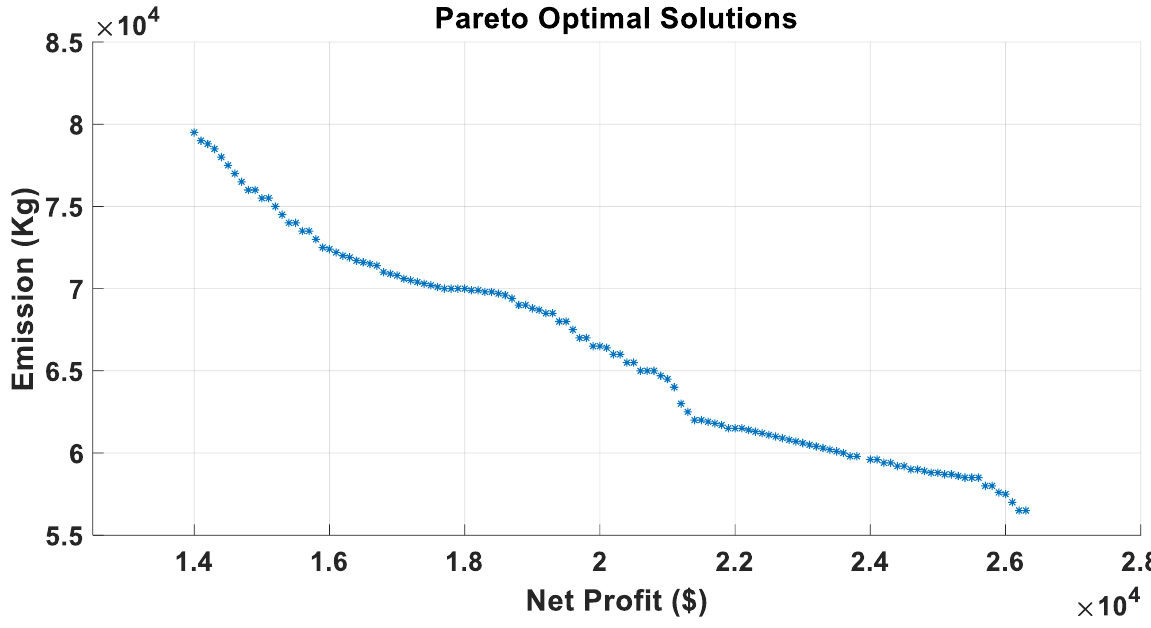
Figure 17. Pareto optimal solutions for Case III of Scenario I (proposed MOBWO technique).